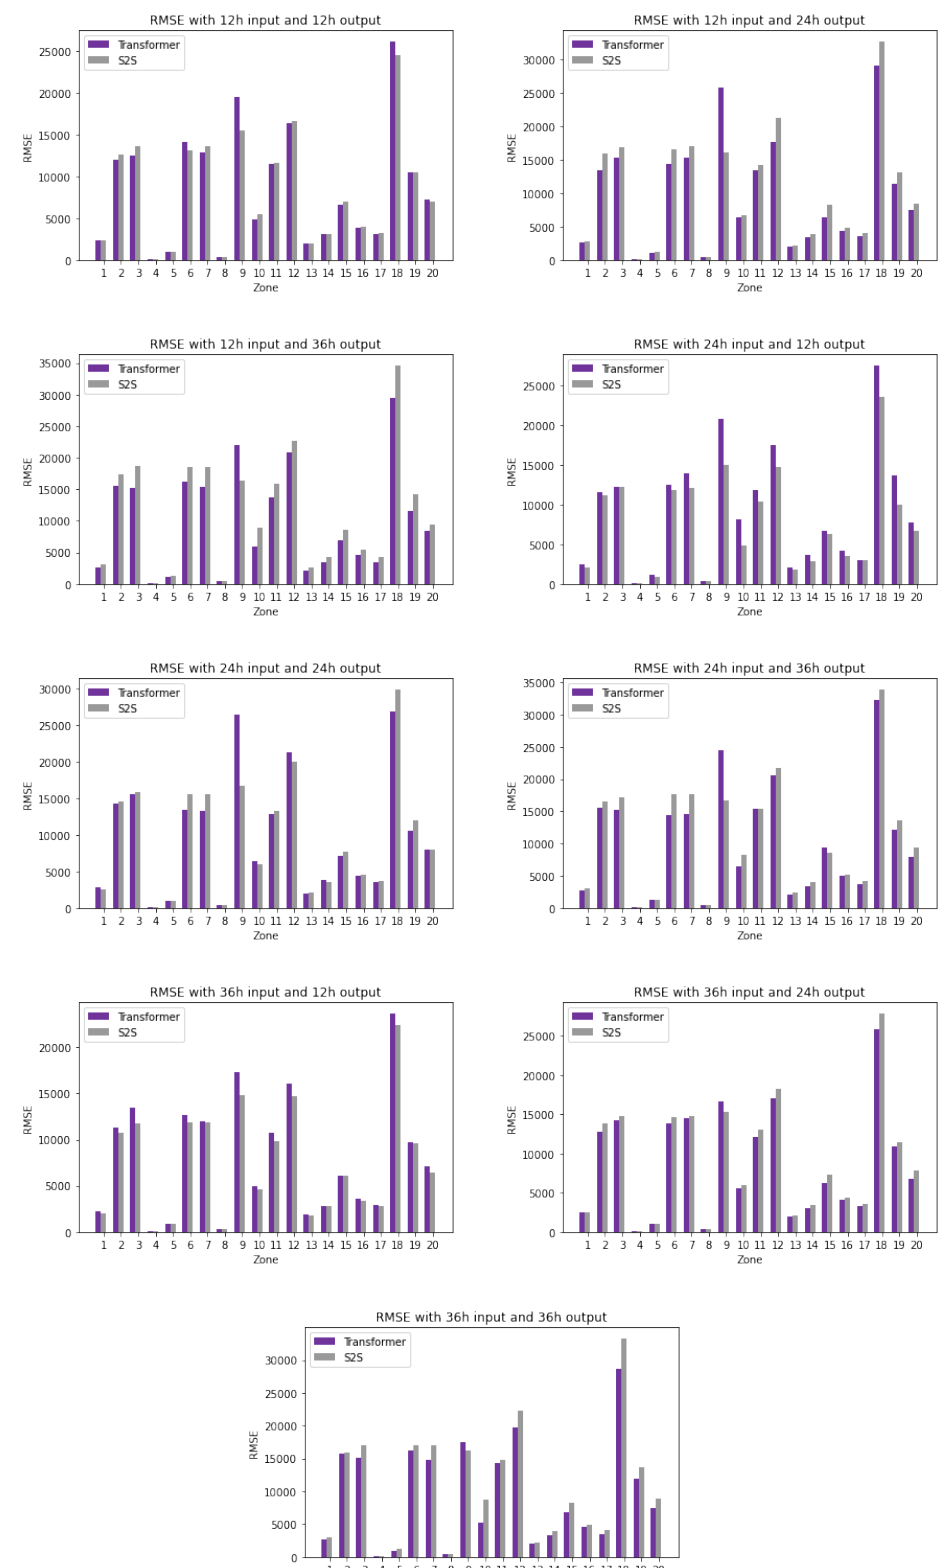
Figure 11. RMSE comparison for each stream under each forecasting horizon and input window size between the transformer model and S2S